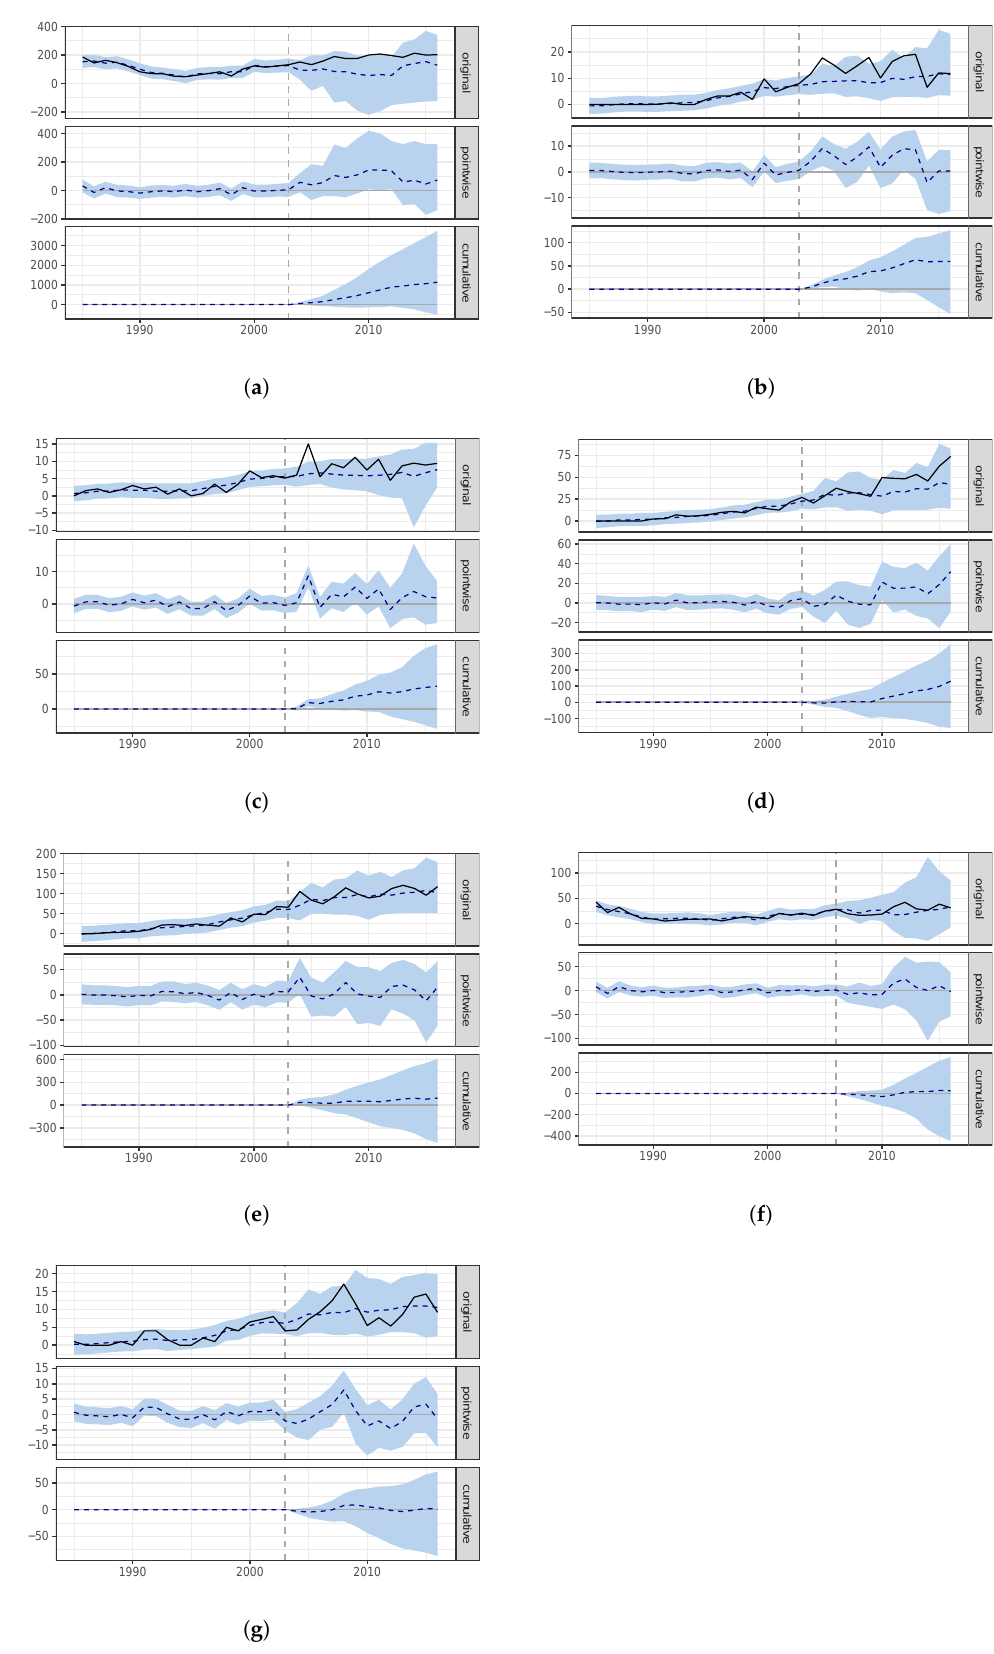
Figure 2. Insignificant causal impact. ( a ) Hungary. ( b ) Latvia. ( c ) Cyprus. ( d ) Slovak Republic. ( e ) Slovenia. ( f ) Bulgaria. ( g )